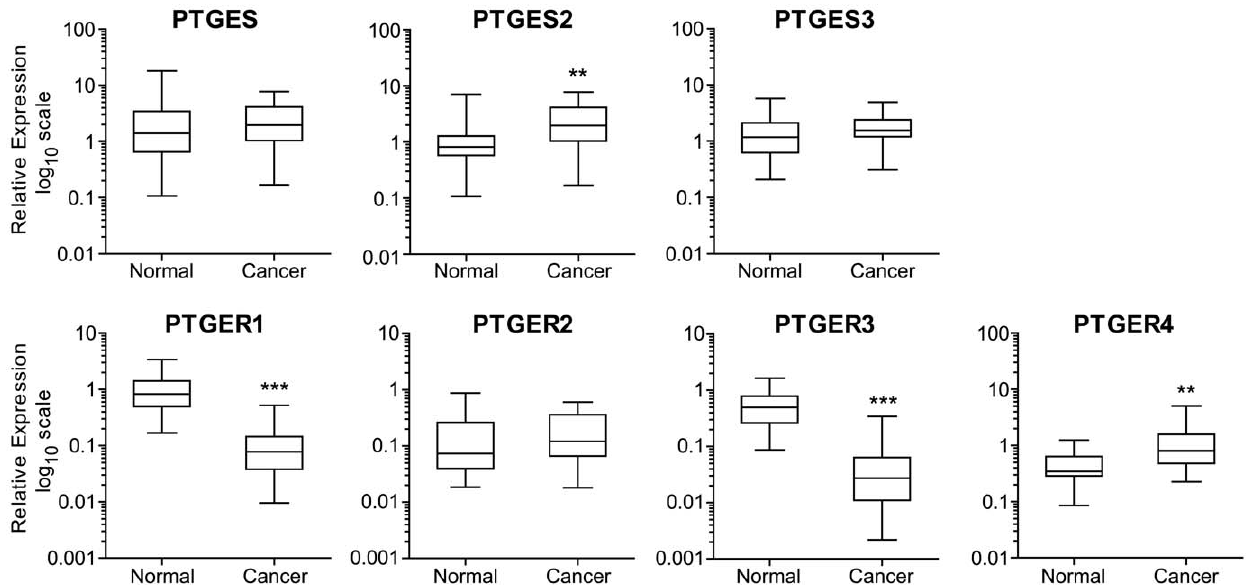
Figure 1. Expression profile of the PTGES-PTGER system in endometrial adenocarcinoma and normal endometrium. mRNA expression of PGE 2 synthase isoforms (PTGES, -2, -3) and E-series prostaglandin receptors (PTGER1–4) in normal endometrium (n=40; comprising a pool of proliferative n=10; early secretory n=10; mid-secretory n=10 and late secretory n=10 phase endometrium) and endometrial cancer (n=29; comprising a pool of poorly differentiated n=10, moderately differentiated n=10 and well differentiated endometrial adenocarcinoma n=9). **, *** represent significance at P , 0.01 and P , 0.001 for cancer vs normal.